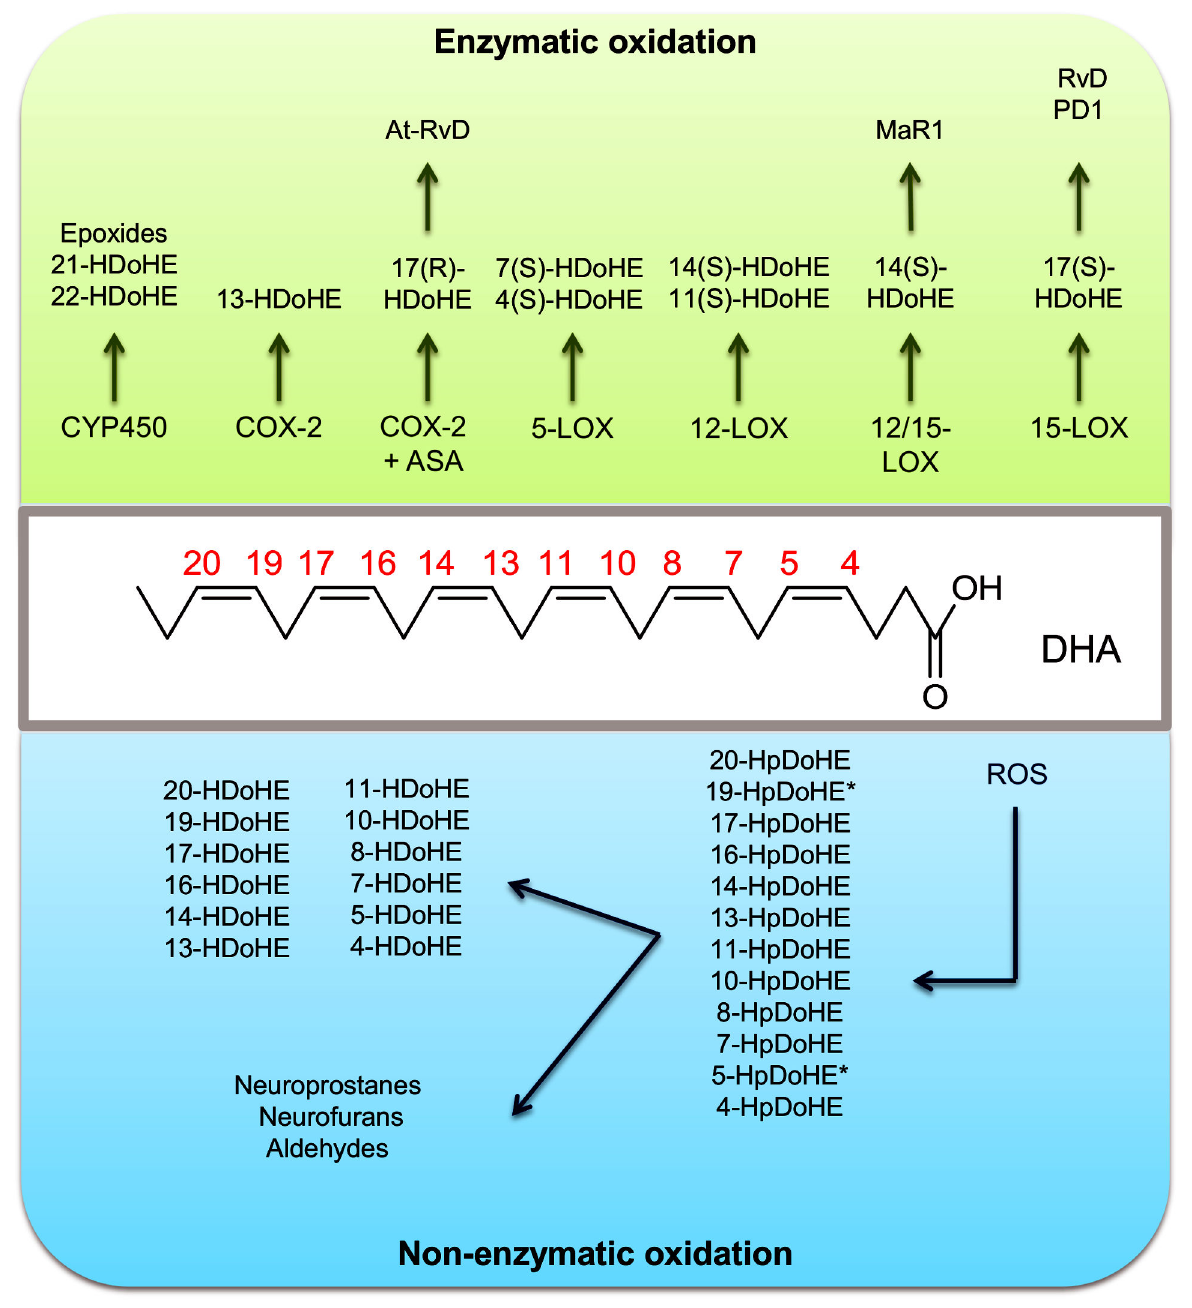
Generation of hydroperoxy, hydroxy and epoxy derivatives of DHA by enzymatic and non-enzymatic mechanisms. *19- and 5-HpDoHE and HDoHE are specifically formed by singlet oxygen oxidation. doi: